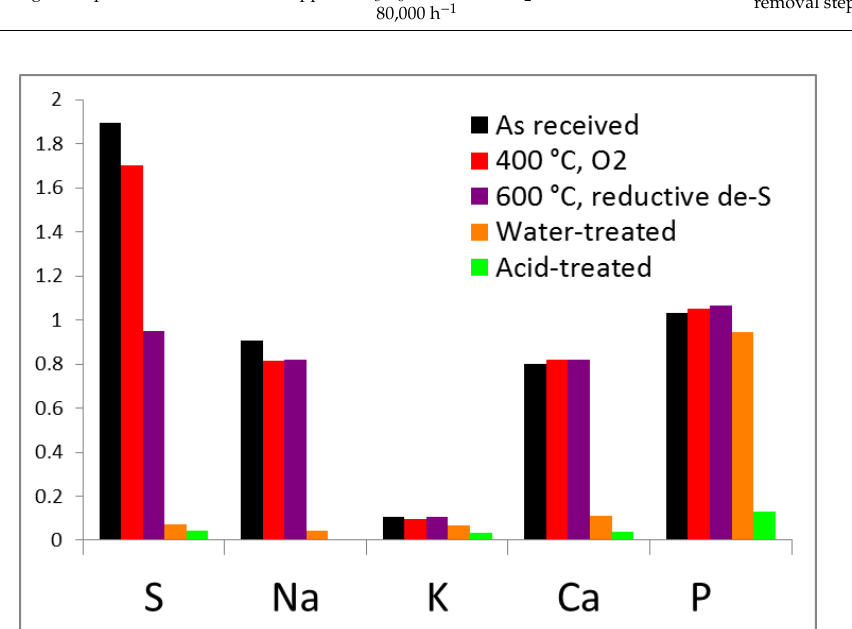
Figure 2. Loading of trace elements in samples taken from the vehicle-aged catalyst (front and rear), as well as in the sample taken from the catalyst aged in an engine cell, as determined by X-ray fluorescence (XRF).